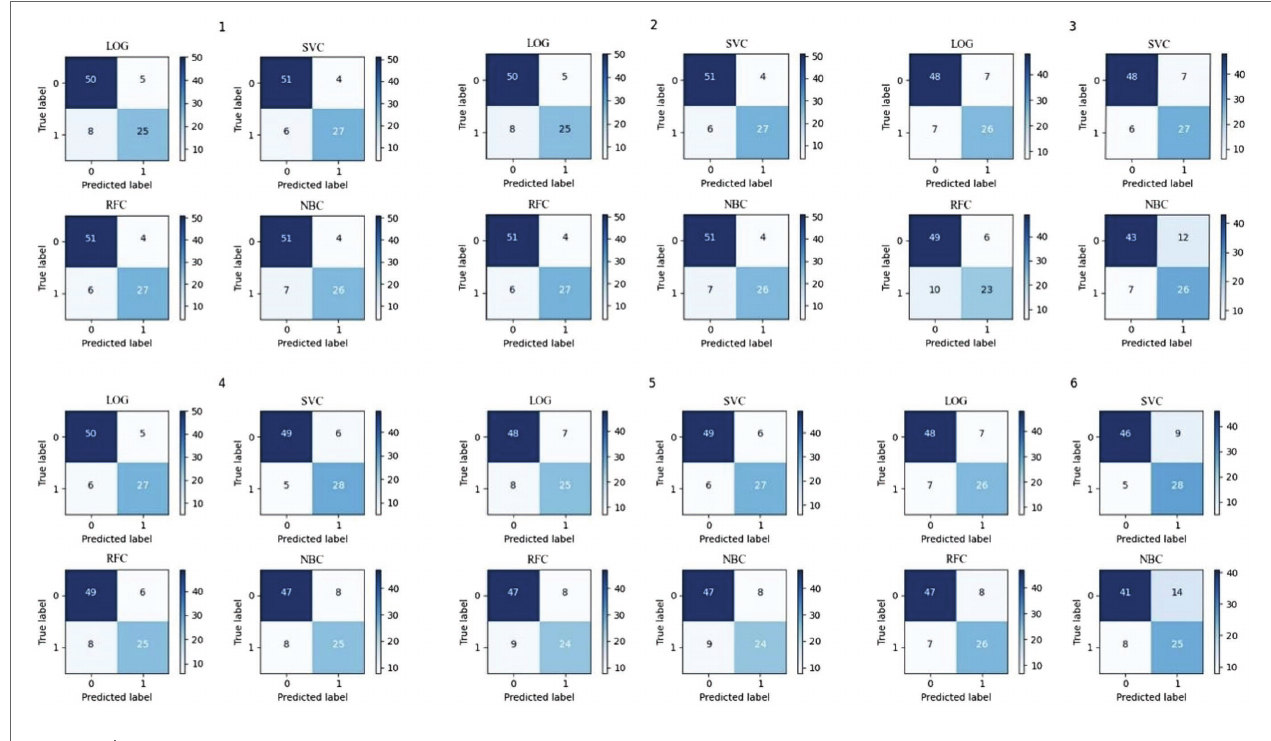
FIGURE 3 | The confusion matrix.